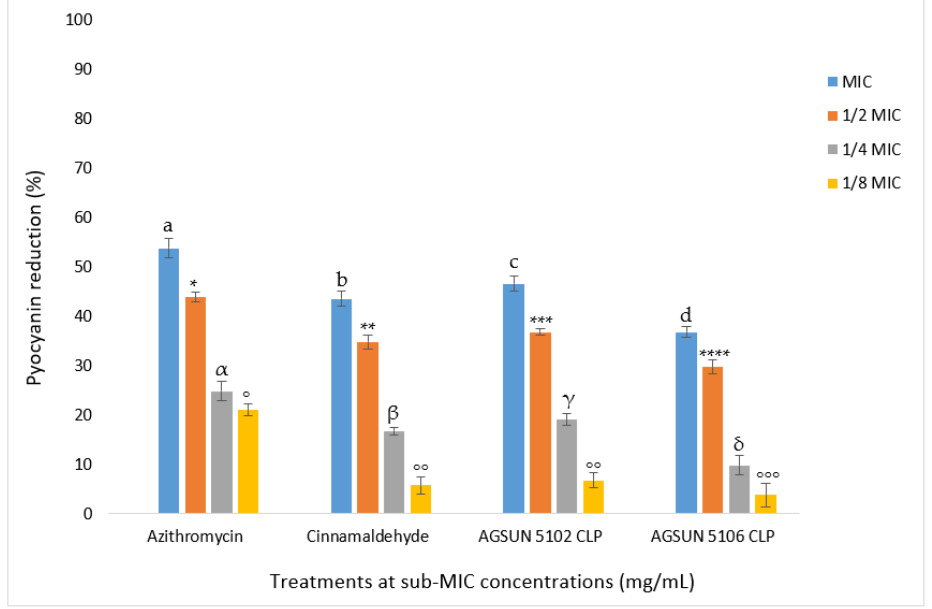
Figure 7. Inhibitory effect of essential oils on QS-mediated virulence factor pyocyanin on P. aeruginosa ATCC 27853 at sub-MIC concentrations (mg/mL) of azithromycin at 0.25–0.031 mg/mL (MIC to 1/8 MIC), cinnamaldehyde at 3.75–0.47 mg/mL (MIC to 1/8 MIC), and both oils (AGSUN 5102 CLP and AGSUN 5106 CLP) at 91.8–11.48 mg/mL (MIC to 1/8 MIC). Letters/symbols represent statistical differences at p- value ≤ 0.05.